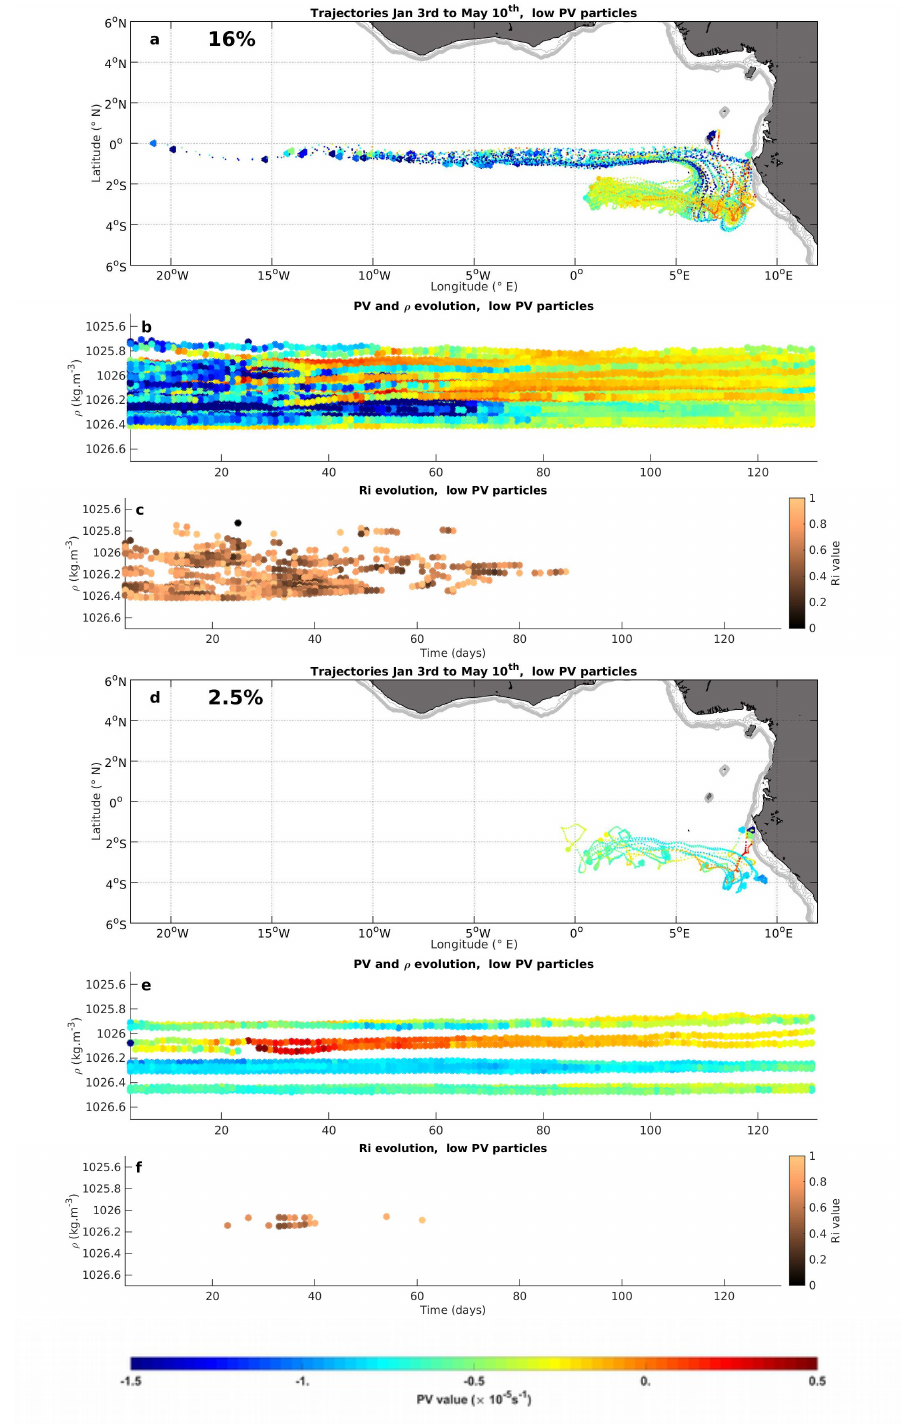
Figure 15. Trajectories ( a , d ), evolution of the density ( b , e ) and of the Richardson number ( c , f ) of low PV particles, eventually constituting part of the vortex core. The initial position is identified by the symbols (cid:47) and the final positions by ∗ on trajectories. Only values below 1 are represented for the Richardson number (indicating the possibility of shear-instability-driven mixing). ( a – c ): particles with low PV values initially located along the Equator. The thin gray lines are isolines of the water depth of the model, from 50 to 500 m; ( d – f ): particles with low PV values initially located south-east of the final position. For ( a , b , d , e ), the color corresponds to the PV value during the evolution (common colorscale given at the